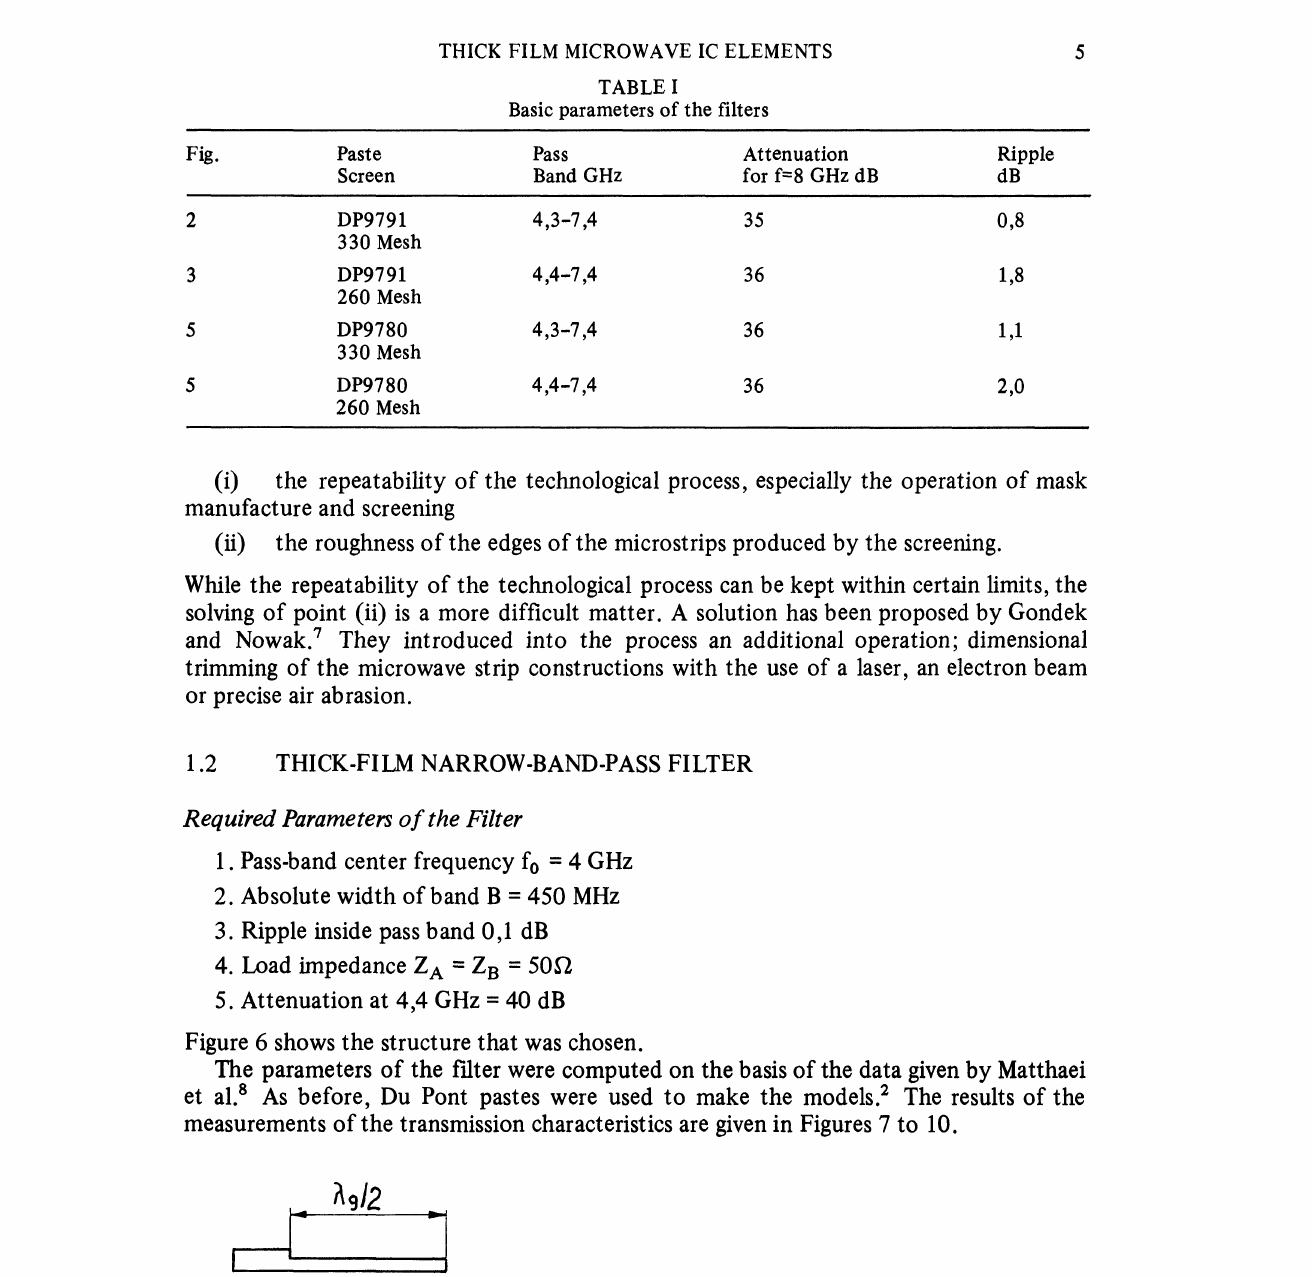
FIGURE 6 Structure of narrow-band-pass